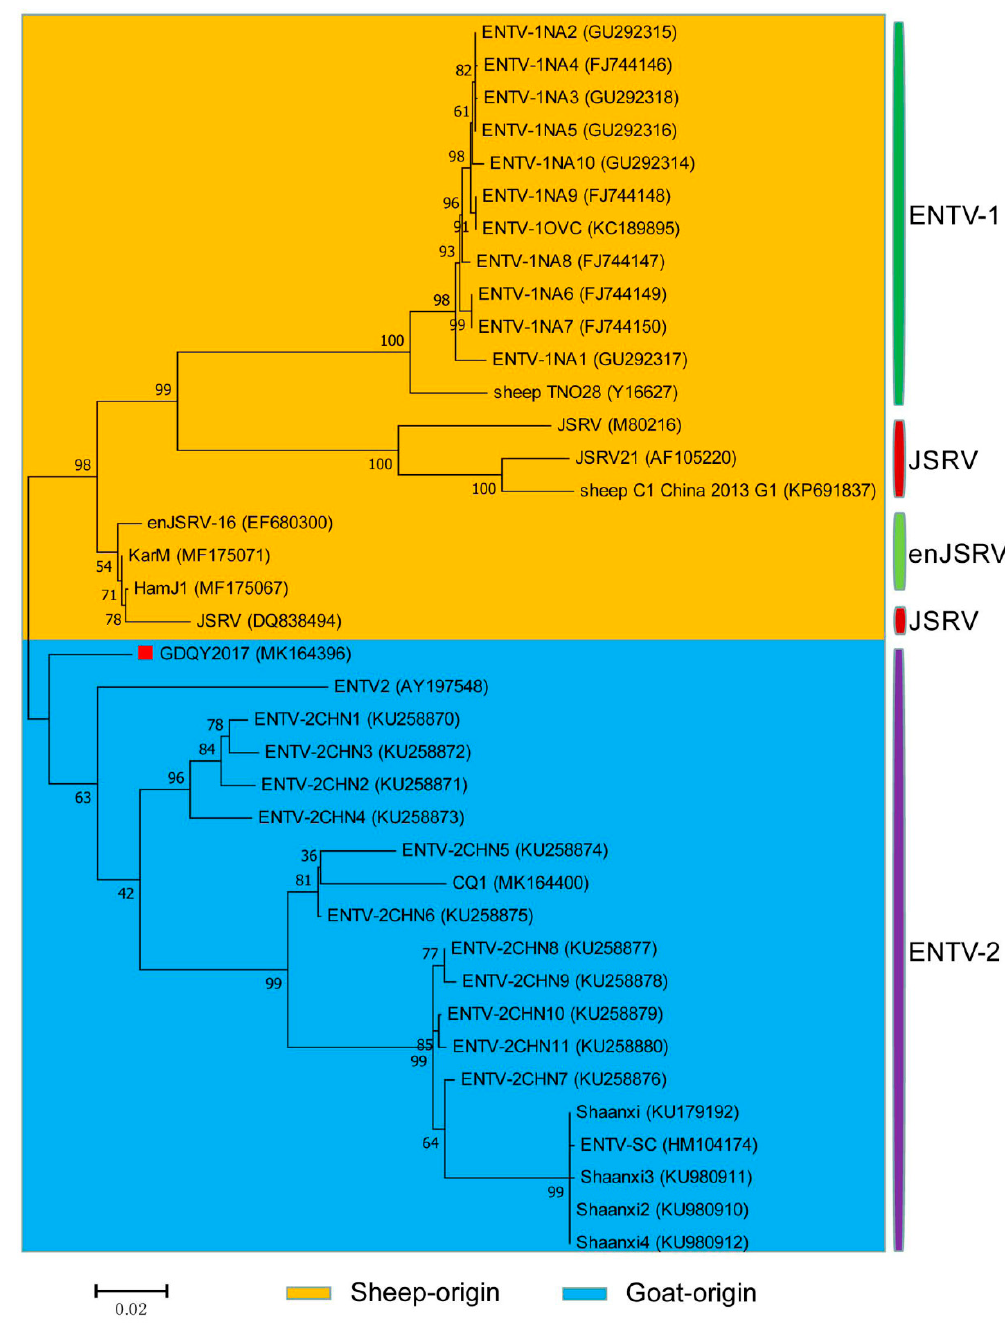
Figure 8. Phylogenetic analysis based on the env gene of ENTV-2 with ENTV-1 and JSRV. GDQY2017 described in this study was marked with the red square.